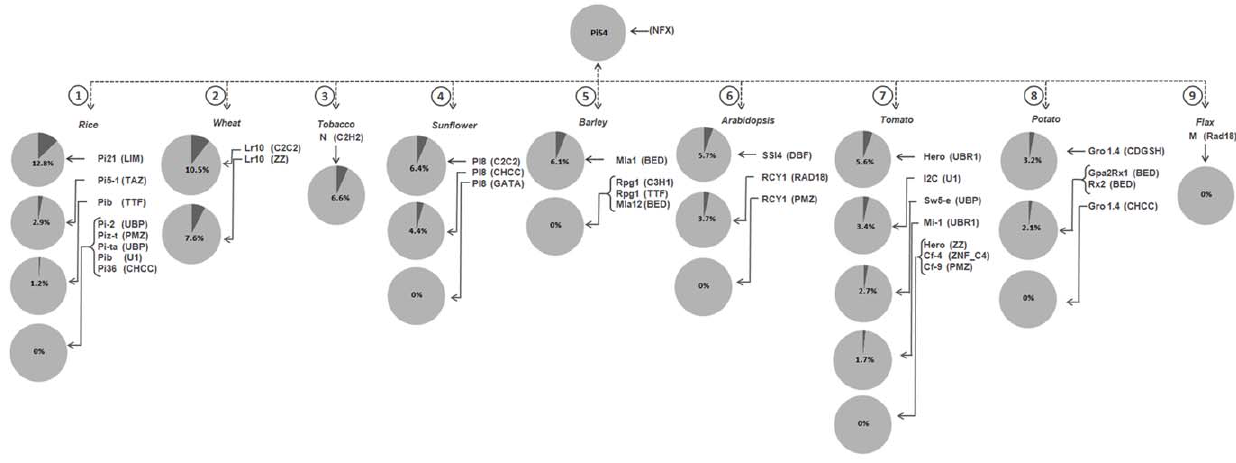
Figure 8. Identity plot of zinc finger domains. Identity plot of zinc fingers represents the identity analysis between amino acid sequences of Pi54 zinc finger domain and zinc finger domains present in cloned R genes of various crops.